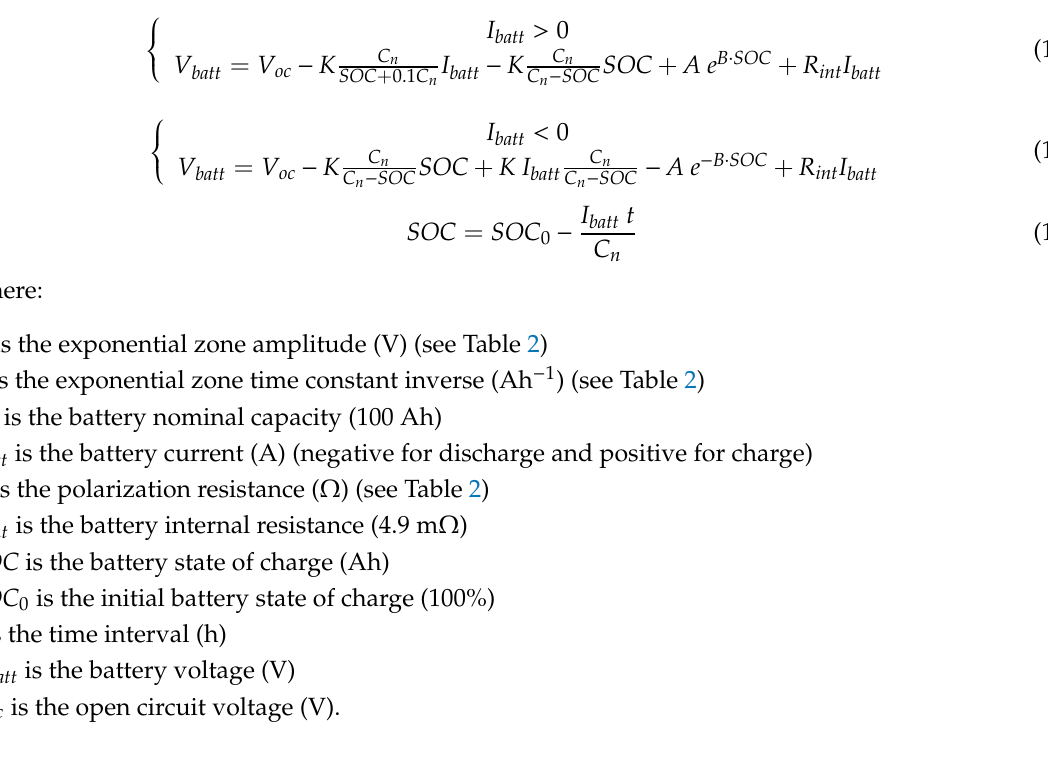
Table 2. Battery experimental data fitting results via MATLAB Curve Fitting